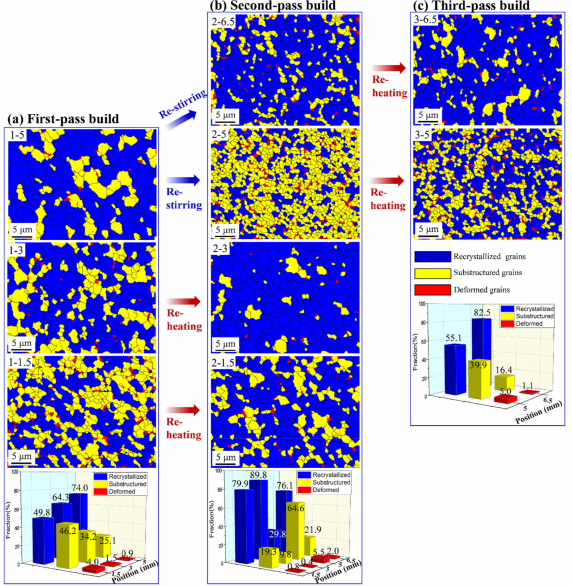
Figure 4. SEM-EBSD recrystallization fraction micrographs of the ( a ) first-, ( b ) second-, and ( c ) third- pass builds together with the histograms of recrystallized, substructured and deformed fractions. The specified positions of the microstructural observation are shown in Figure 3a–c, marked with the red